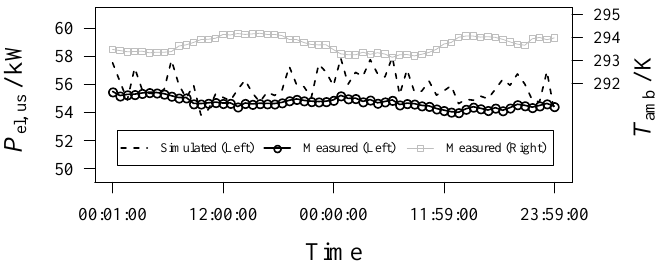
Figure 9. Useful electrical power of the MGT and ambient air temperature vs. time. The simulated values were obtained by means of the input signals specified in Figure 8. The maximum absolute discrepancy for P el,us was about